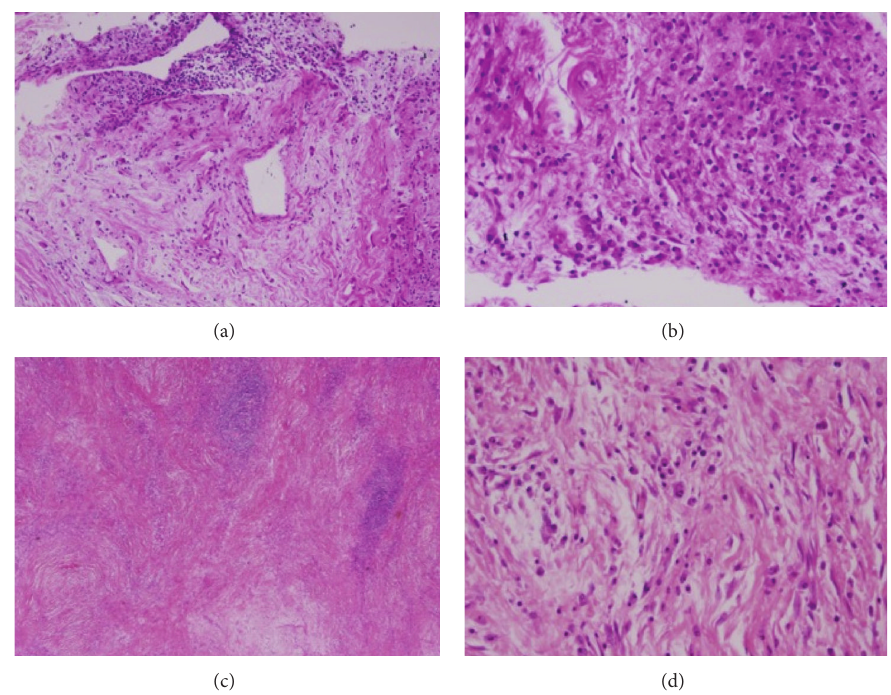
Figure 3: Microscopic examination showing a variably cellular tumor consisting of hypocellular collagenized fibrous areas and intervening myxoid areas (a, c) with mildly atypical spindle cells and dense inflammatory infiltrates of lymphocytes and plasma cells (b, d).